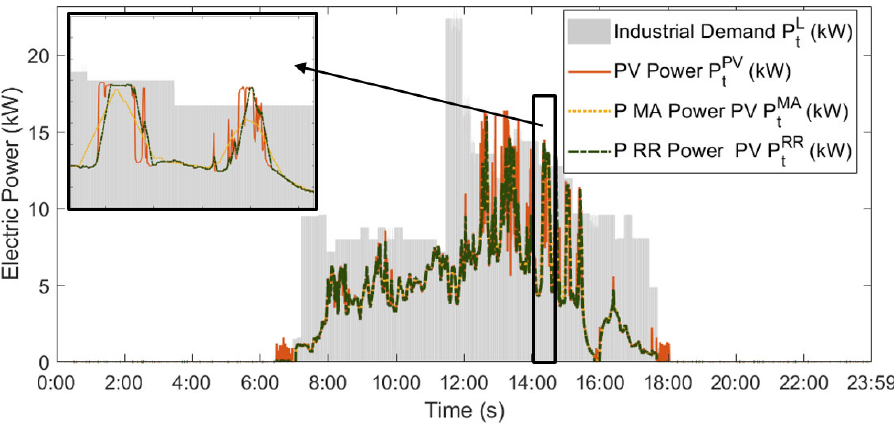
Figure 7. Control algorithm response, power smoothing methods for a system (PV + SC).